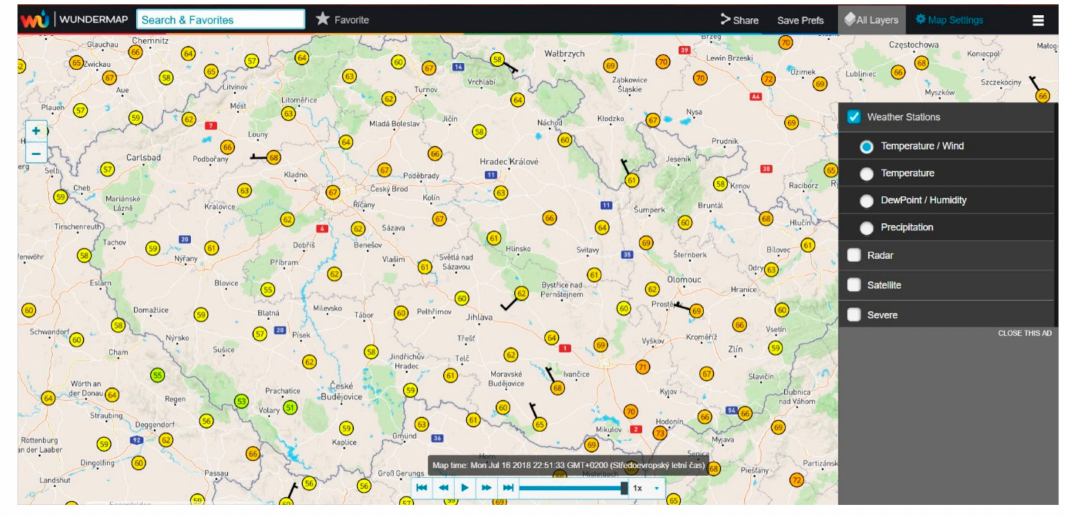
Figure 5. Wundermap map preview. The map has a simple composition with switching between the tabs (all layers, map settings). The sample map presents the temperature and